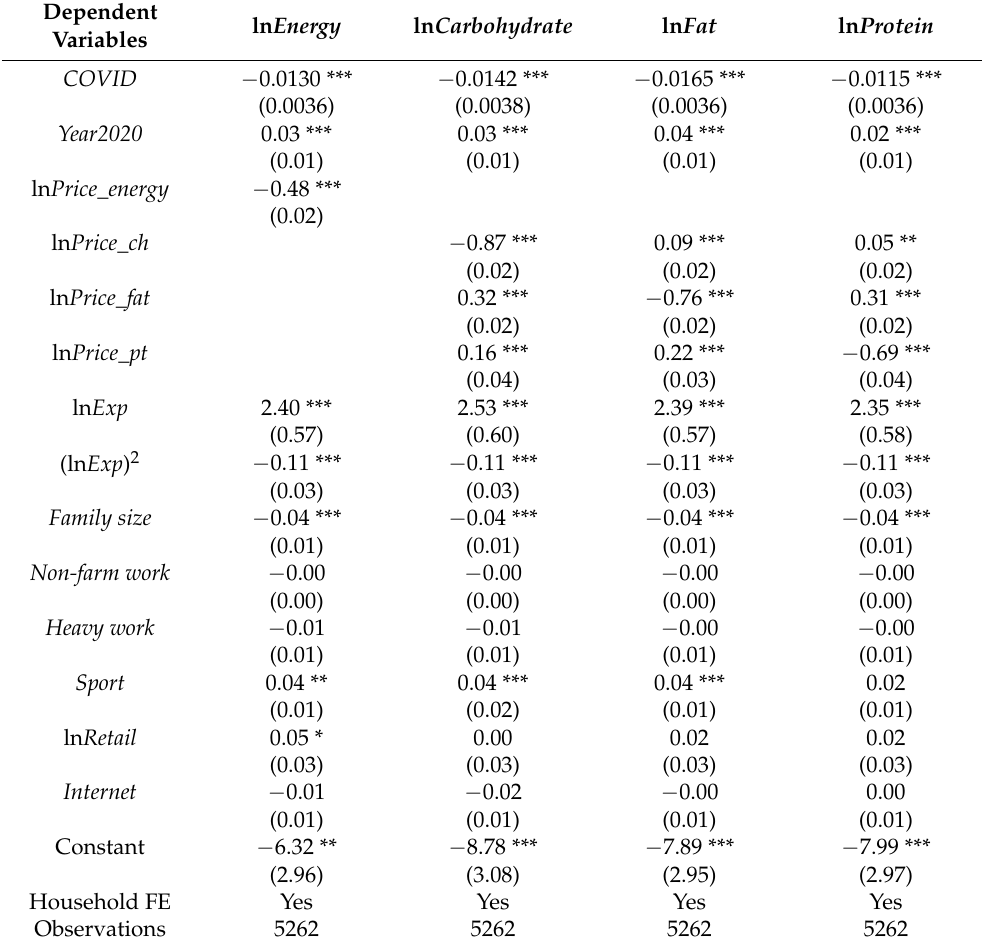
Table A1. Estimation results from the ordinary fixed effect model.